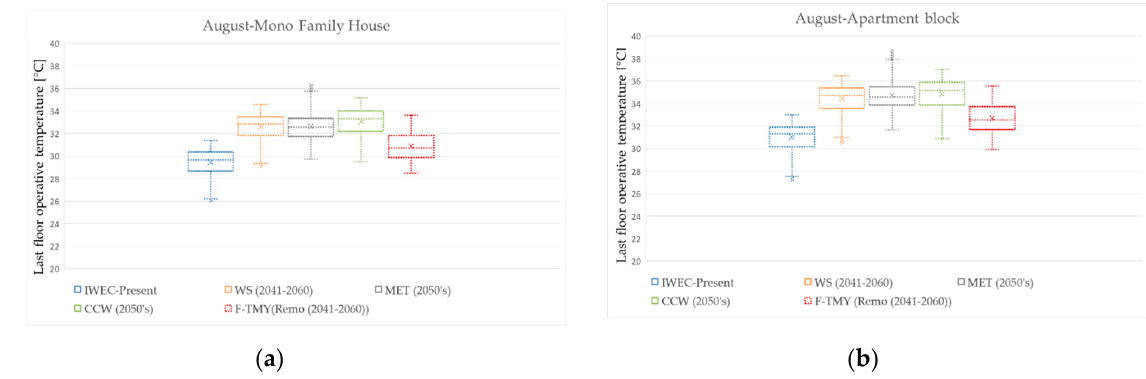
Figure 7. Boxplot of last floor operative temperature of a mono family house ( a ) and apartment block ( b ) in August, for IWEC (Present), Weathershift (WS), Meteonorm (MET), CCWorldWeatehr-Gen (CCW), and F-TMY. All future weather files are for 2050s considering RCP 8.5. Table 1. Electrical energy demand per unit of area and hours of exceedance for a mono family house (MFH) and apartment block (AB), for IWEC (Present), Weathershift (WS), Meteonorm (MET), CCWorldWeatehr-Gen (CCW), and F-TMY. All future weather files are for 2050s considering RCP